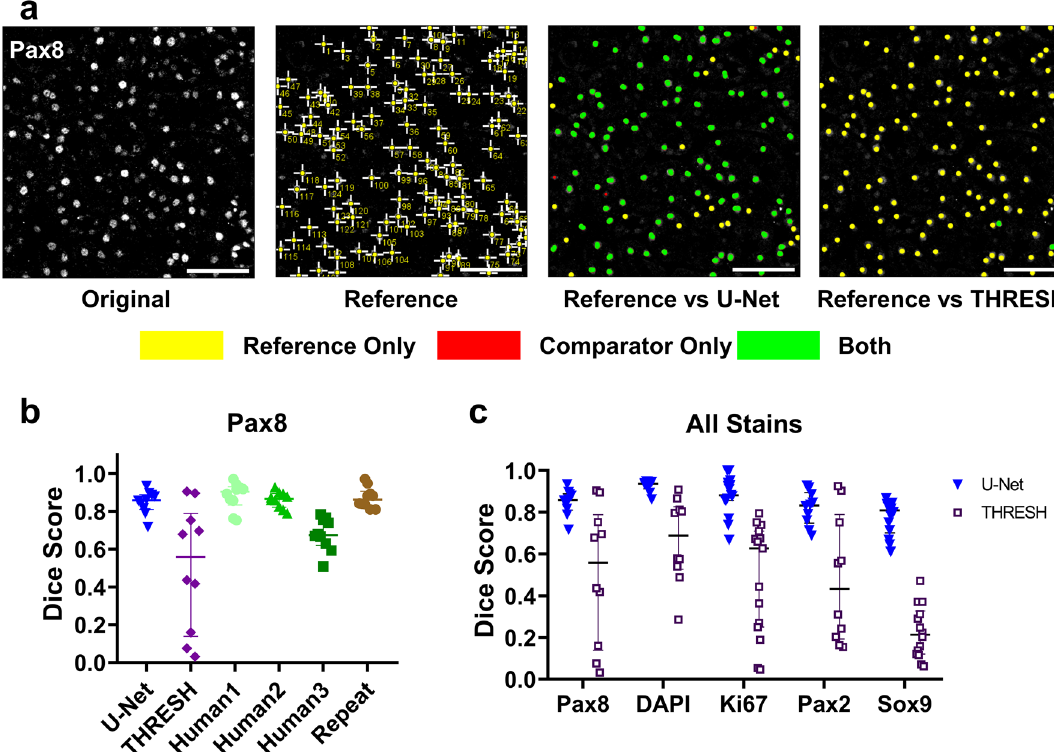
Figure 3. U-Net segmentation performance is similar to human annotation and superior to thresholding for nuclear-localized stains. ( a ) U-Net was trained to identify unambiguously positive Pax8 expressing nuclei as described. Random sample ROIs were extracted from U-Net segmentations of whole kidney sections and the coordinates of individual positive nuclei were determined. Nuclear coordinates were compared with the locations of nuclei marked by an expert reference annotator (crosses). Pairs of matching coordinates were determined (within 5 μm, only one match per annotation, marked by a pair of green dots linked by a green line). Scale bar = 50 μm. ( b ) Matched and unmatched coordinates were used to calculate a Dice score for each image comparing the reference observer to U-Net, thresholding of the background-subtracted section (THRESH), independent trained human annotators (Human1, Human2, Human3), and the reference observer’s re-annotation of blinded, randomly reordered, randomly rotated images (Repeat). Median + interquartile range are shown. ( c ) U-Net models were trained for several additional nuclear-localized stains (DAPI, Ki67, Pax2, and Sox9). Dice scores were compared with